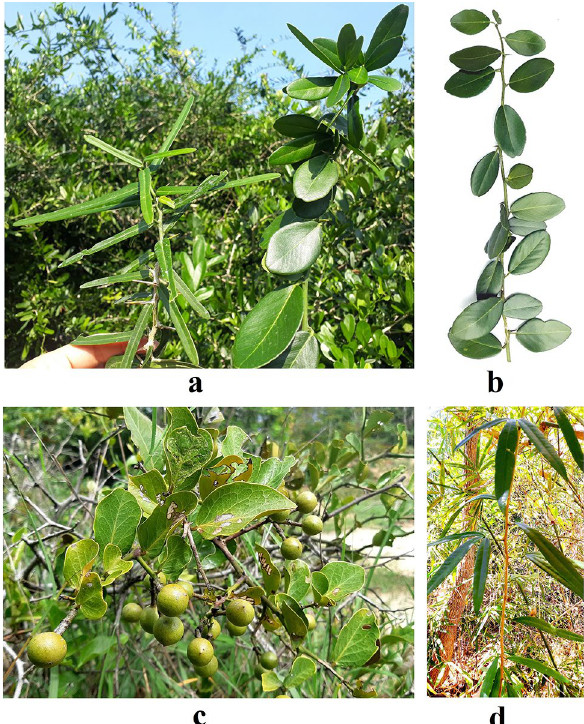
Figure 4. Morphological characteristics of four species of different genera. A single individual plant of P. trimera with two different forms of leaves ( a ), typical morphology of A. buxifolia ( b ), the scrambling shrub of S. monophyla with fruits ( c ), and the typical morphology of L. scandens with different types of leaves ( d ).